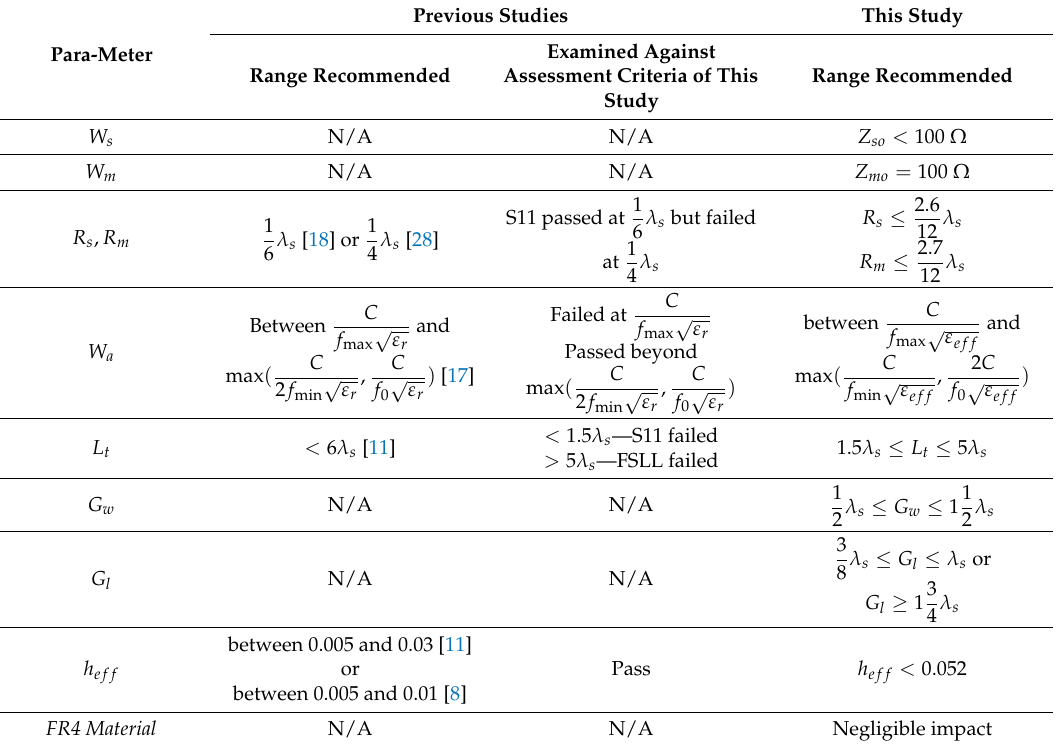
Table 4. Comparison with previous